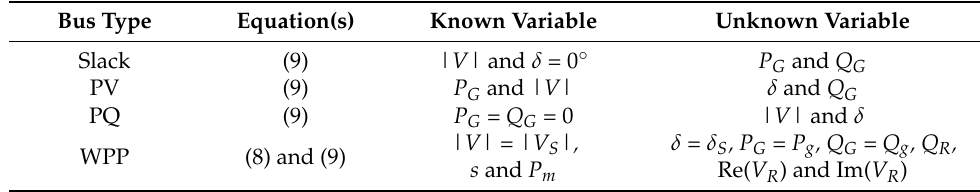
Table 2. Equation and variable.